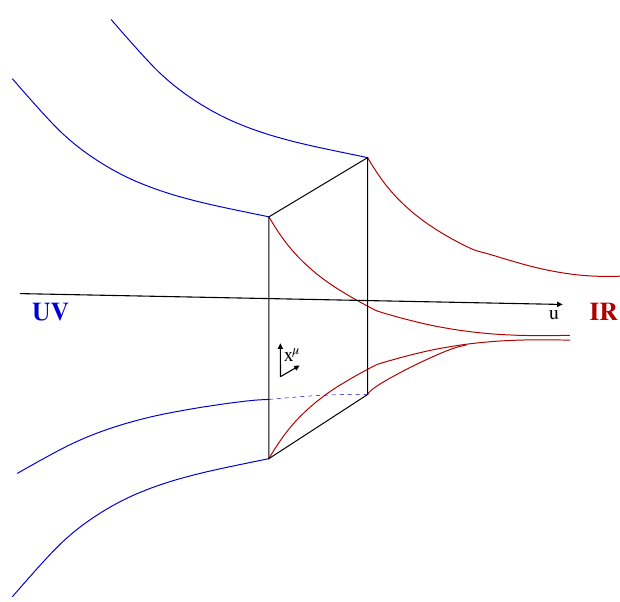
Figure 1 . Sketch of the Holographic RG-(cid:13)ow solutions, with the brane acting as the interface between an in(cid:12)nite volume UV region and a (cid:12)nite volume IR region. The coordinates x (cid:22) are world-volume four-dimensional coordinates on the brane-world, u represents the holographic radial